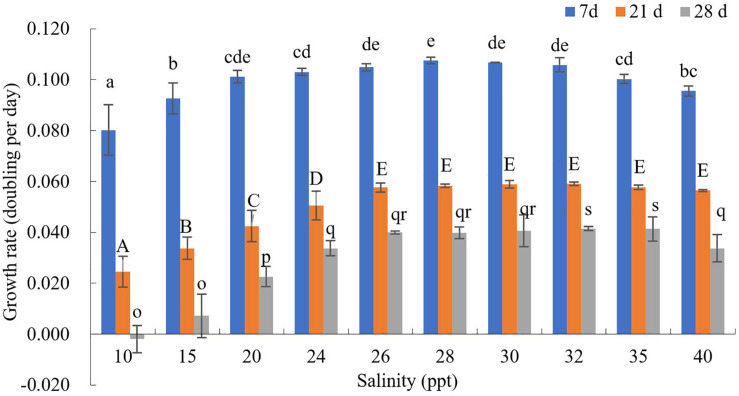
The growth rate (K, doubling/day) of GF19C1 under a series of salinity (ppt) gradient. Superscripts in a-e, A-E, and o-s denote three ANOVA multiple comparisons, followed by Tukey post hoc to locate the significant differences. Different letters within the same comparison group mean significant difference (ANOVA, P < 0.05). Each salinity has three replicates (n = 3). The error bars stand for standard deviation (SD).